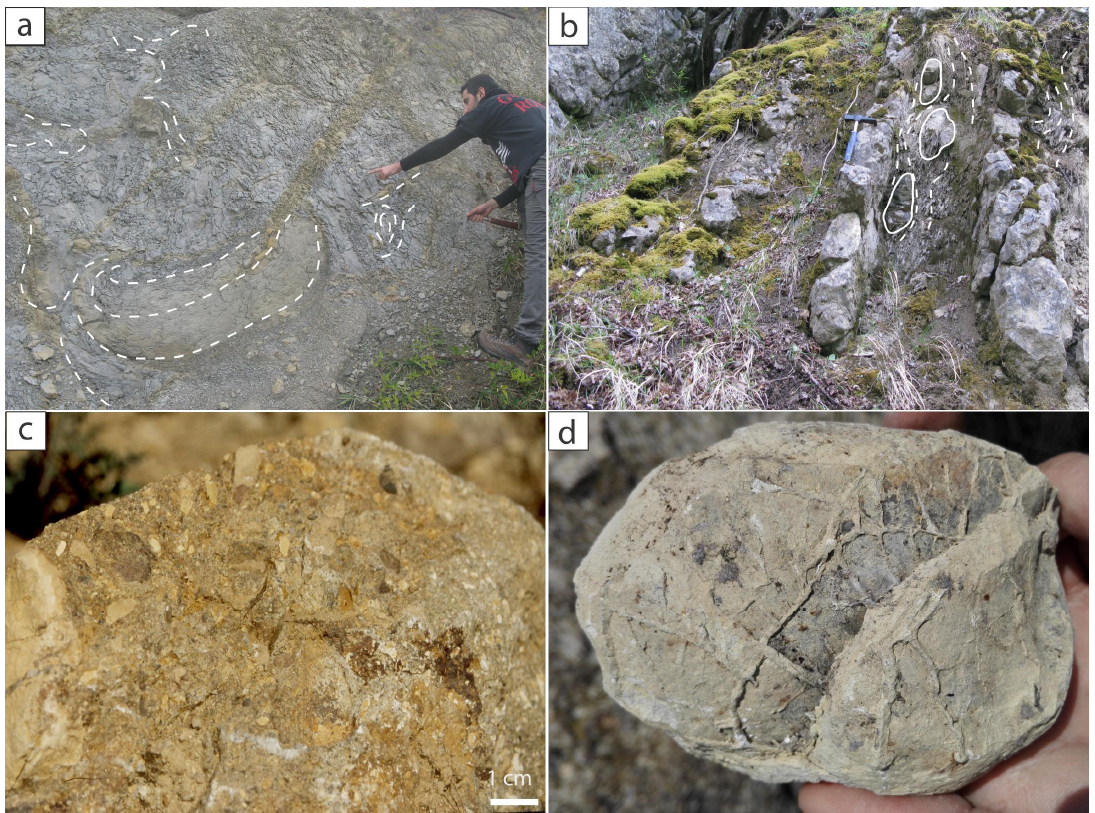
Figure 6. Examples of fluid expulsion structures: ( a , b ) Soft‐sediment deformation structures and disrupted strata in host sediment in proximity of the seep carbonate body (COR outcrop in Figure 1). ( c ) Debris flow deposits cemented by 13 C‐depleted micrite (DE outcrop of Figure 1). ( d ) Septaria‐like concretion made up of depleted methane‐derived carbonates (BU outcrop of Figure 1).